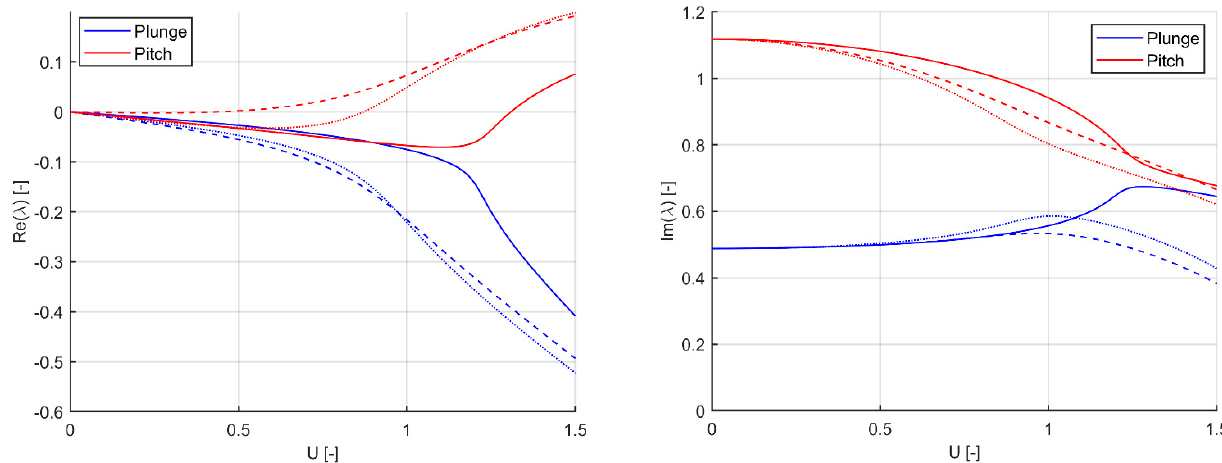
Figure 6. Evolution of the complex eigenvalues for Case B: real part ( left ), imaginary part ( right ); continuous, dashed and dotted lines for QU, QS and SQS aerodynamic models, respectively.